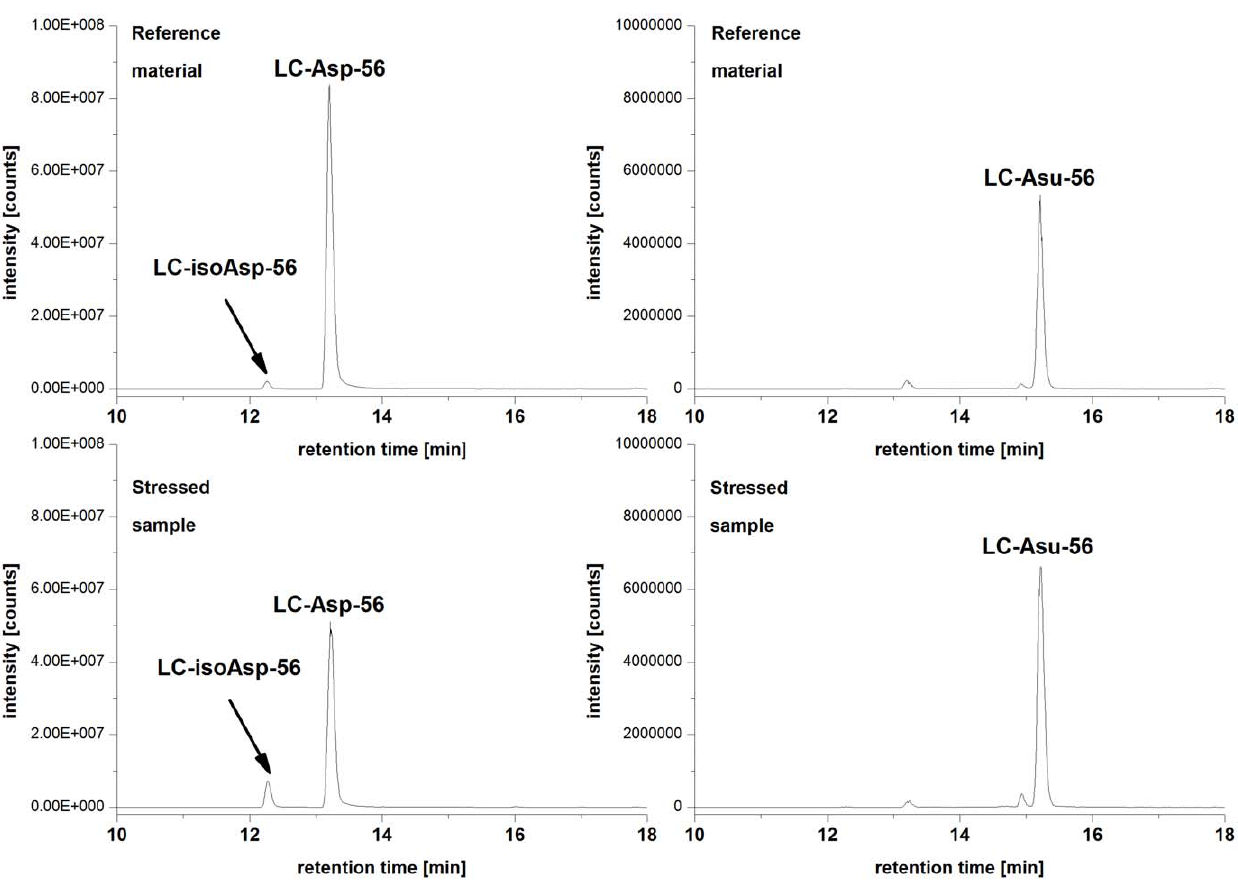
Figure 7. Specific ion chromatograms (SICs) of Mab1 peptides containing LC-Asx-56. M=841.47 Da (z=1, and 2) (LC-Asp-56; LC-iso-Asp- 56) and M=823.46 Da (z=1, and 2) (LC-Asu-56) from the Mab1 reference material and a stressed sample (stored at 40 u C for 2 month).